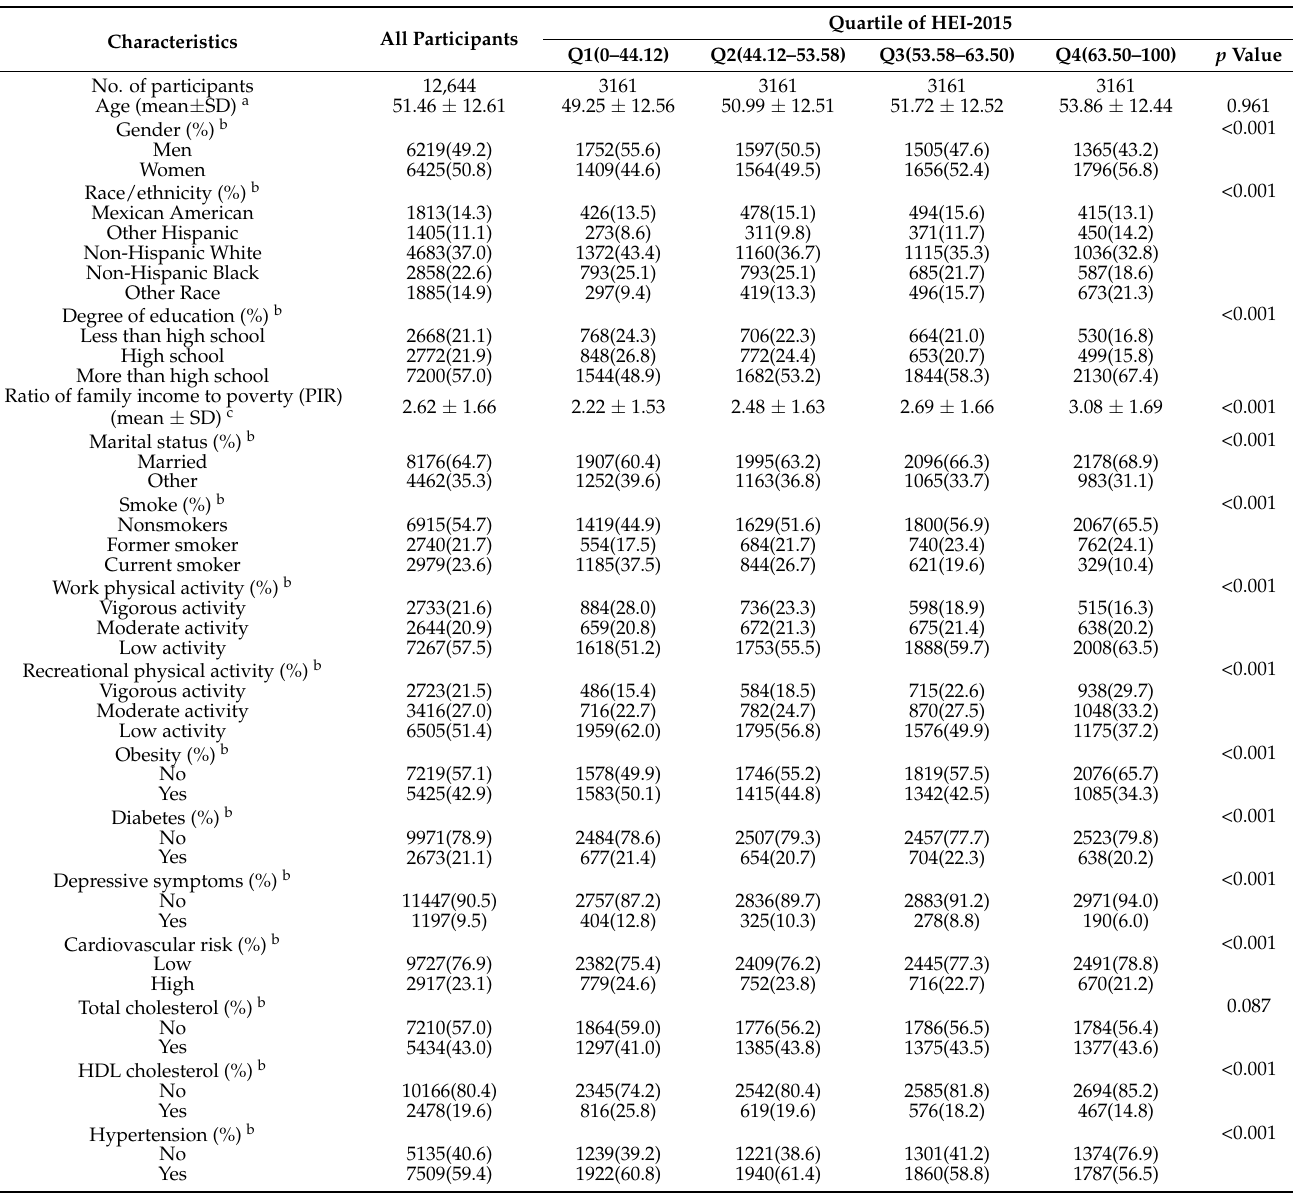
Table 1. Basic characteristics of the included sample ( n =